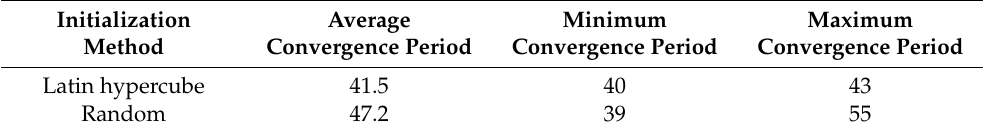
Table 3. Comparison of convergence